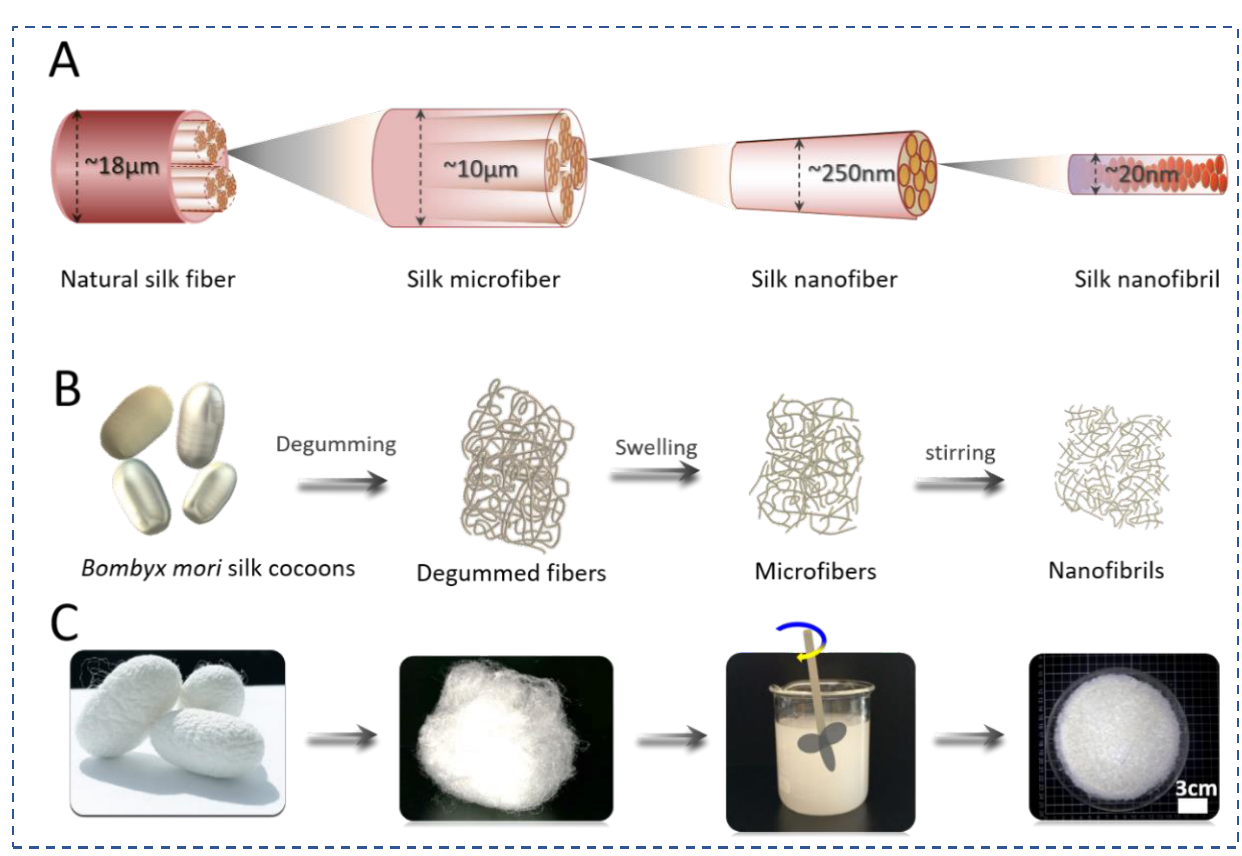
Figure 1. Schematic illustration of the SNFs fabrication process. ( A ) Schematic showing the fabrication of SNFs, ( B ) The process of SNFs via mechanical shearing, ( C ) the morphology changes of the silk fibers during SNF preparation from silk fibers and microfibers.